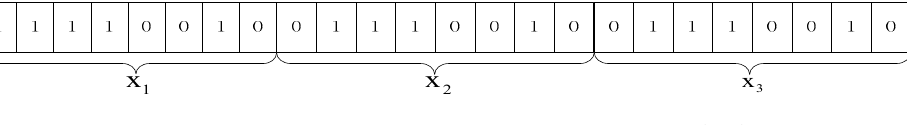
Figure 7. Schematic diagram of mutation.